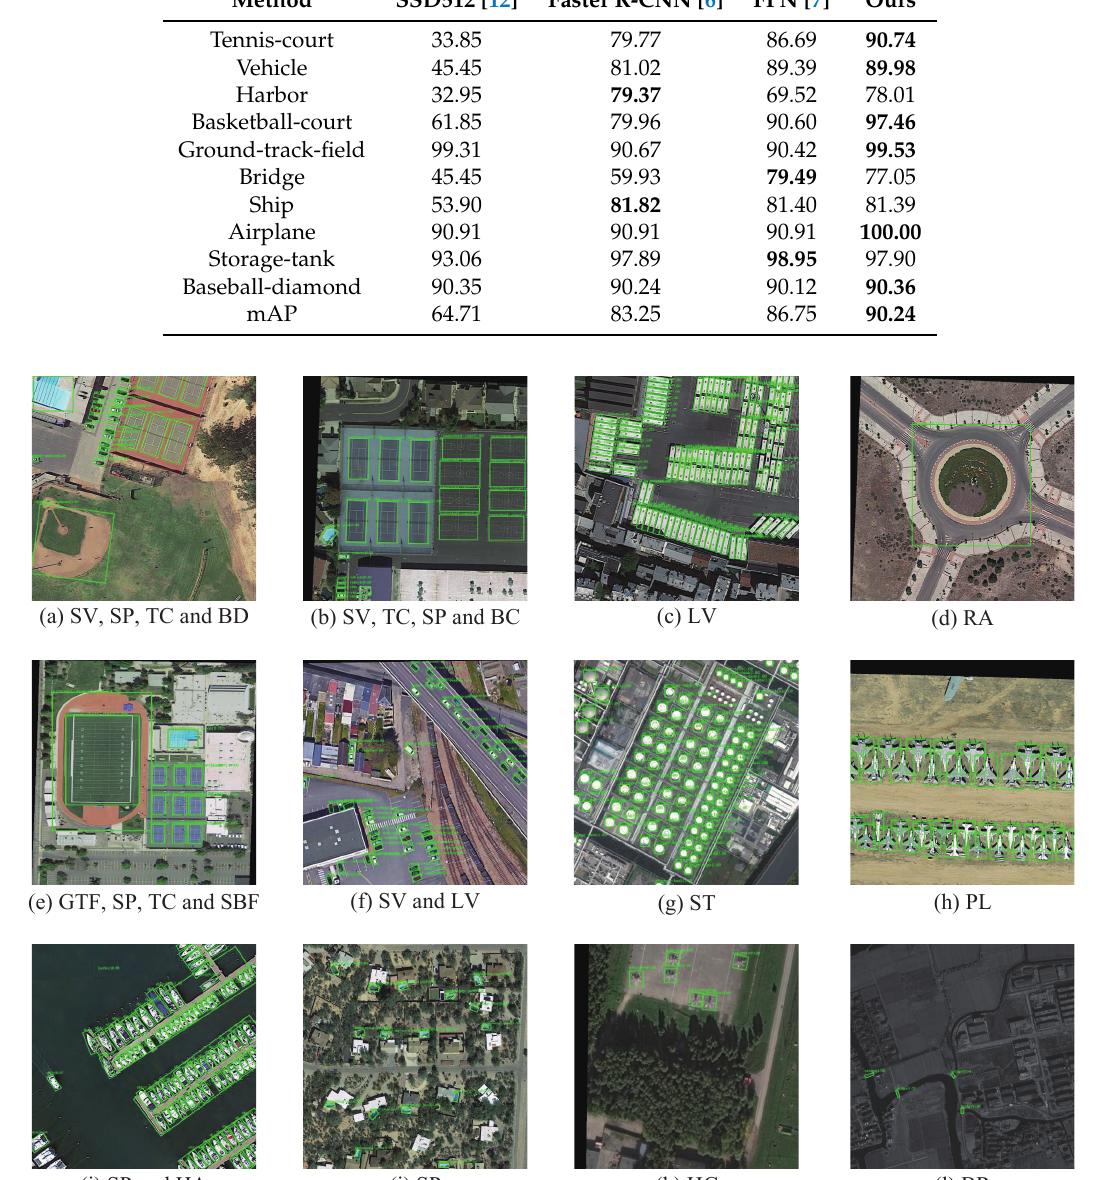
Figure 7. Examples of RADet’s detection results on DOTA dataset. ( a ) Detection results of Small vehicle (SV), Swimming pool (SP), Tennis court (TC) and Baseball diamond (BD). ( b ) Detecton results of Small vehicle (SV), Tennis court (TC), Swimming pool (SP) and Basketball court (BC). ( c ) Detection results of Large vehicle (LV). ( d ) Detection results of Roundabout (RA). ( e ) Detection results of Ground track field (GTF), Swimming pool (SP), Tennis court (TC) and Soccer-ball field (SBF). ( f ) Detection results of Small vehicle (SV) and Large vehicle (LV). ( g ) Detection results of Storage tank (ST). ( h ) Detection results of Plane (PL). ( i ) Detection results of Swimming pool (SP) and Harbor (HA). ( j ) Detection results of Swimming pool (SP). ( k ) Detection results of Helicopter (HC). ( l ) Detection results of Bridge